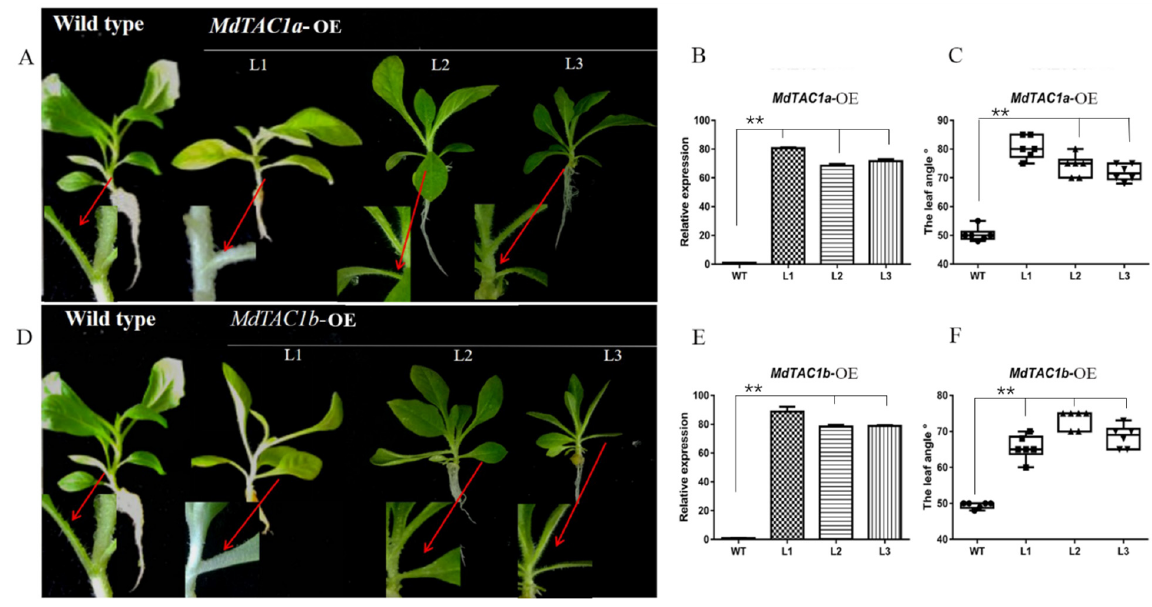
Figure 2. Phenotypes, leaf angles, and relative expression levels of MdTAC1a and MdTAC1b in transgenic tobacco plants. ( A , D ) Phenotypes of MdTAC1a -OE and MdTAC1b -OE transgenic plants. ( B , E ) The relative expression levels of MdTAC1a in MdTAC1a -OE and MdTAC1b in MdTAC1b -OE transgenic plants. ( C , F ) Leaf angles of MdTAC1a -OE and MdTAC1b -OE transgenic plants. WT: the wild type; L1–L3: the transgenic lines. The significance of difference was analyzed with two-tailed t -test (** p < 0.01).